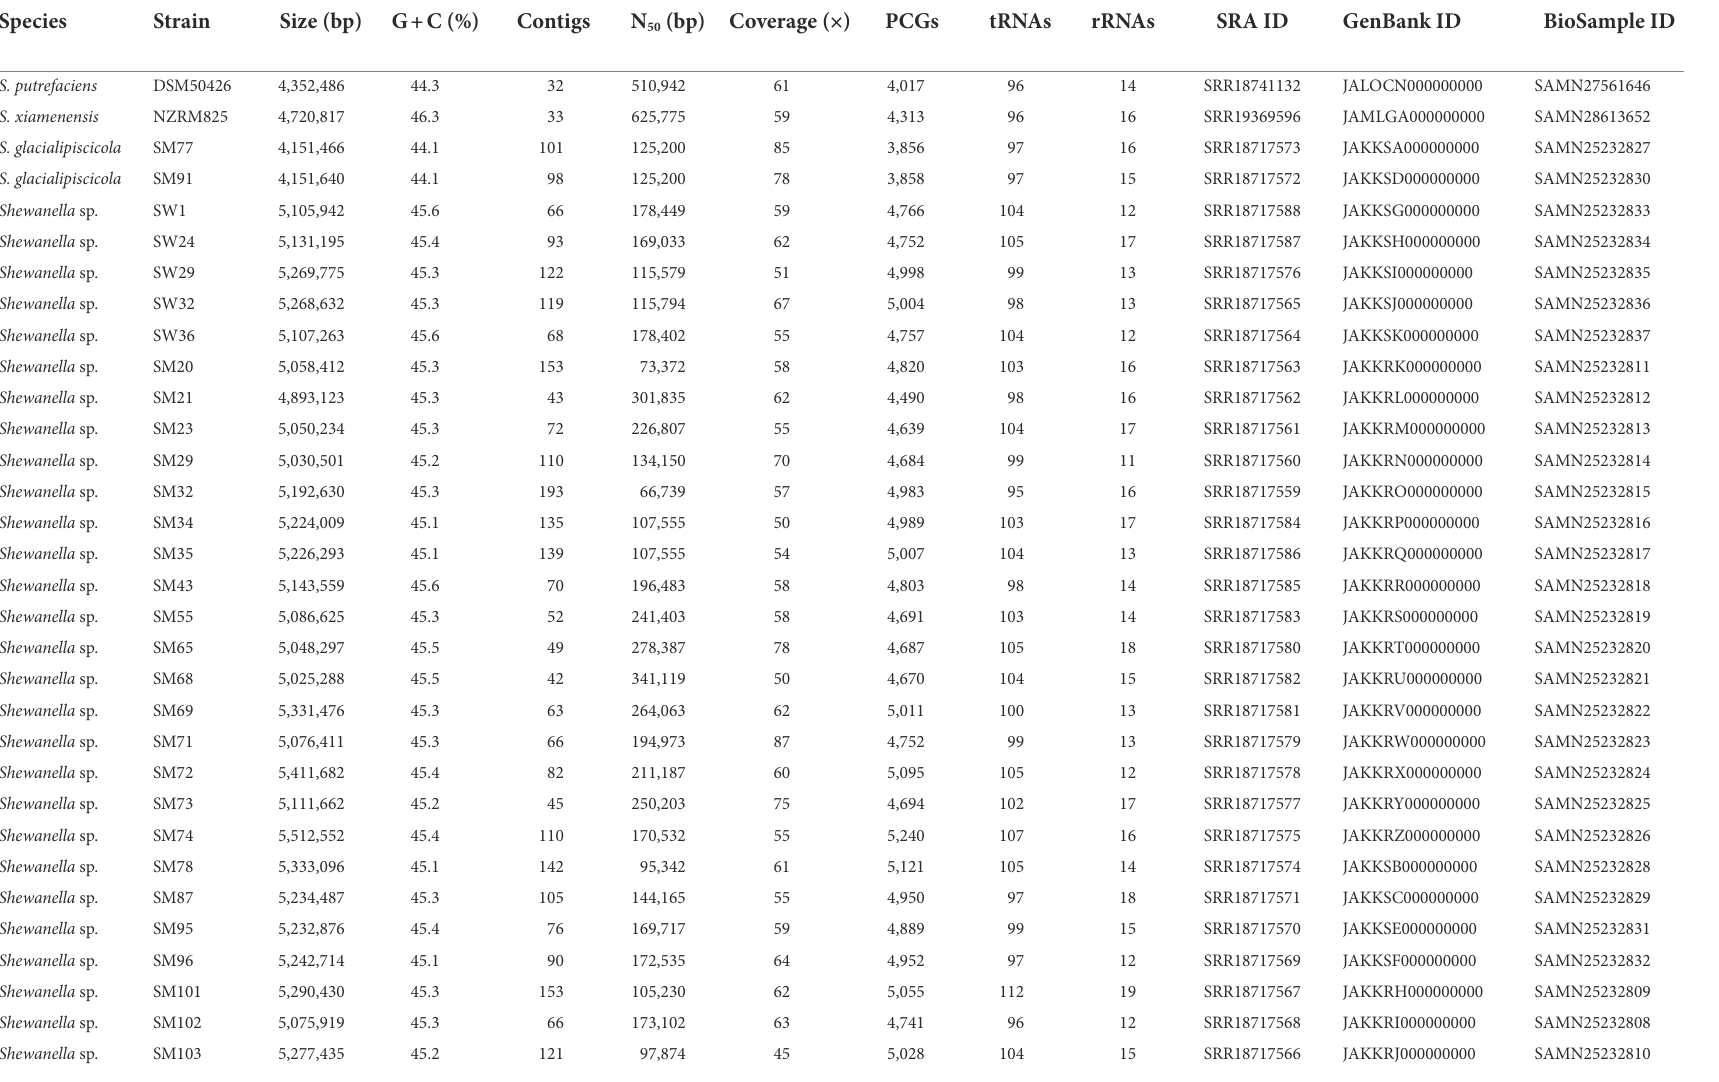
TABLE 1 General genome features of Shewanella spp.